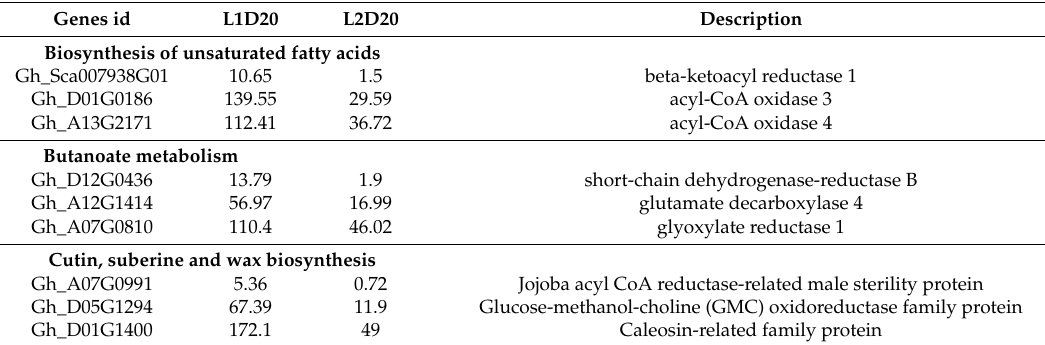
Table 3. FPKMs and functional categories of genes significantly upregulated in L1 on